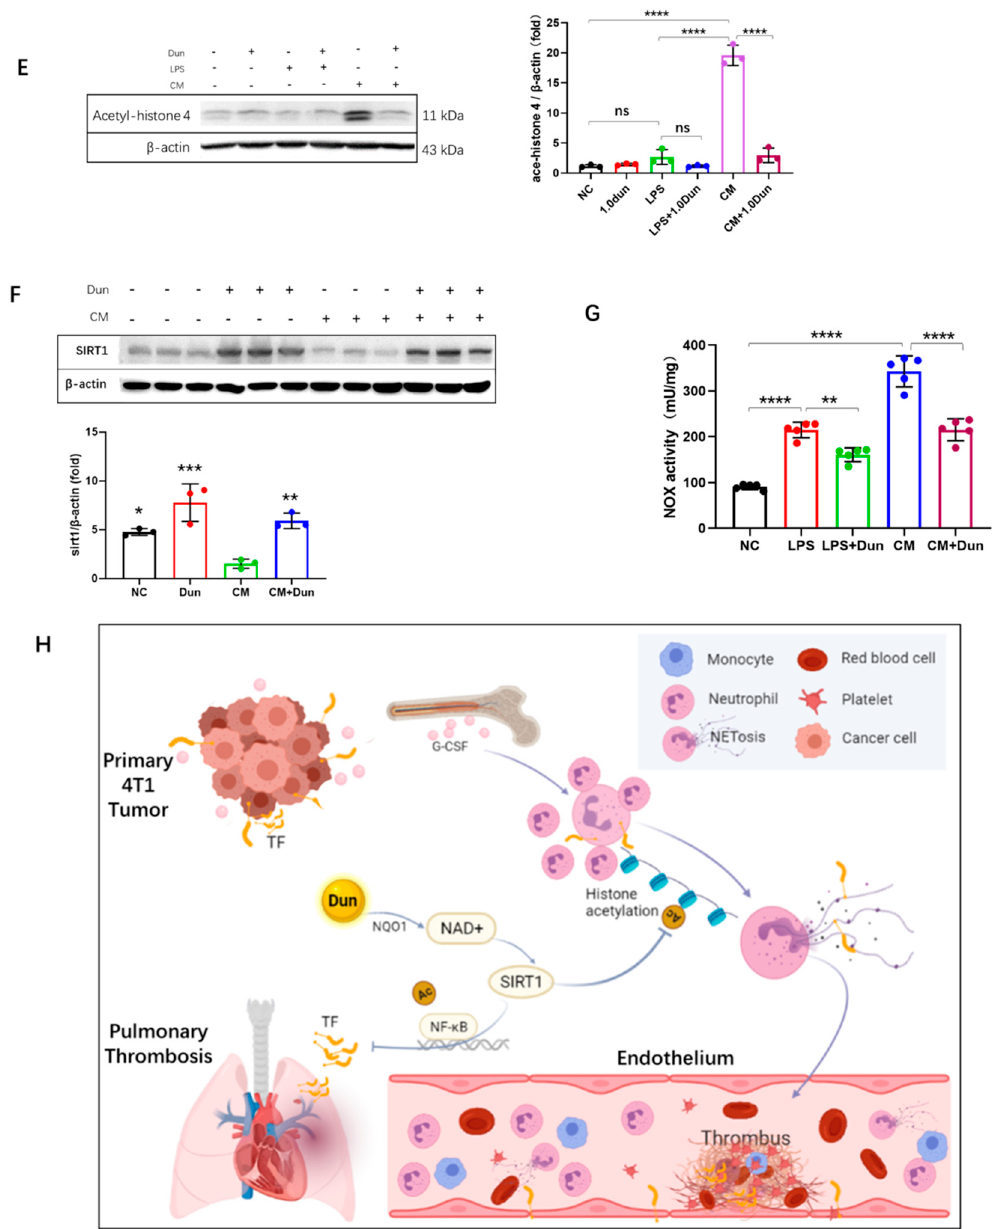
Figure 5. Tumor cells increase the formation of NETs by promoting histone acetylation and NOX activity of neutrophils, which could be attenuated by dunnione. Neutrophils were co − treated with the negative control (Roswell Park Memorial Institute (RPMI) medium), cancer cells conditioned medium, LPS (25 μ g/mL) or phorbol myristate acetate (PMA) (5 μ M) and dunnione (1.0 μ M) for 3 h. ( A ) Flow cytometry and Wright − Giemsa staining to identify the purity of Percoll isolated neutrophils from the bone marrow of normal healthy mice. ( B ) MPO (green) immunostaining with DAPI (blue) counterstain in isolated neutrophils. Scale bar, 50 μ m. ( C ) Quantification of cell − free DNA in supernatants of cultured neutrophils by Quant − iT PicoGreen dsDNA kit ( n = 9 per group). ( D ) Acetyl-Histone 4 (red) combined with DAPI (blue) immunostaining of neutrophils from each treated group. Scale bar, 50 μ m. ( E , F ) Western blotting analysis of acetyl − histone 4 ( E ) and SIRT1 ( F ) in neutrophils ( n = 3 per group). Densitometric analysis is presented as the fold induction of acetyl − histone 4 or SIRT1 relative to β− actin. Significances of SIRT1 expression as compared to the negative control samples. ( G ) NOX activity in neutrophils was measured using an NADH oxidase activity assay kit according to the manufacturer’s instructions. ( H ) An overview schematic illustrating the regulatory effects of dunnione on cancer-associated lung thrombosis. Data represent the mean ± SD. p − values were obtained by one − way ANOVA. ns, not significant; * p < 0.05; ** p < 0.01; *** p < 0.001; **** p < 0.0001.